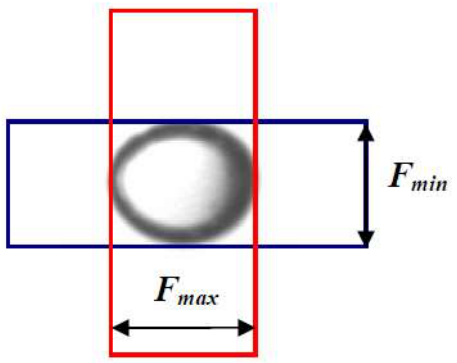
Figure 2. Measurement of bubble diameter.